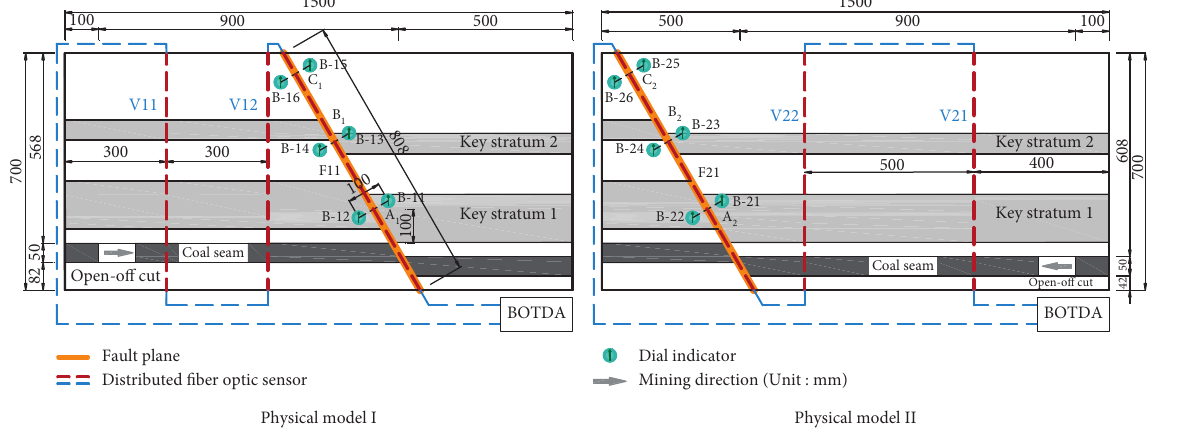
Figure 3: Similarity model test system.